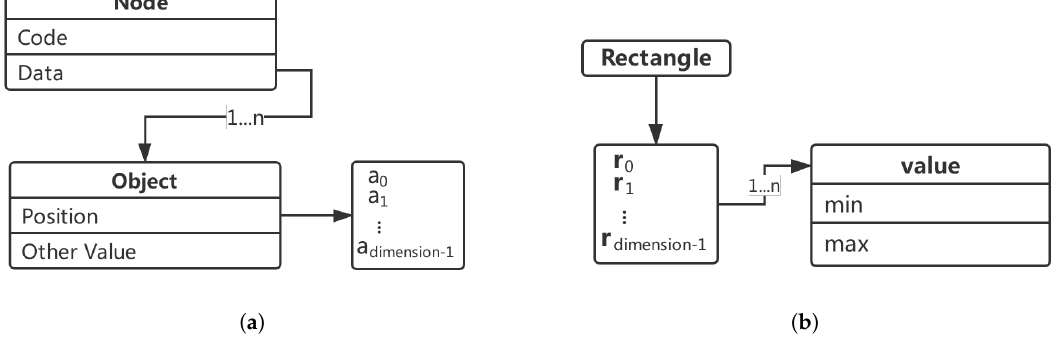
Figure 4. ( a ) Structure of spatial node, ( b ) structure of